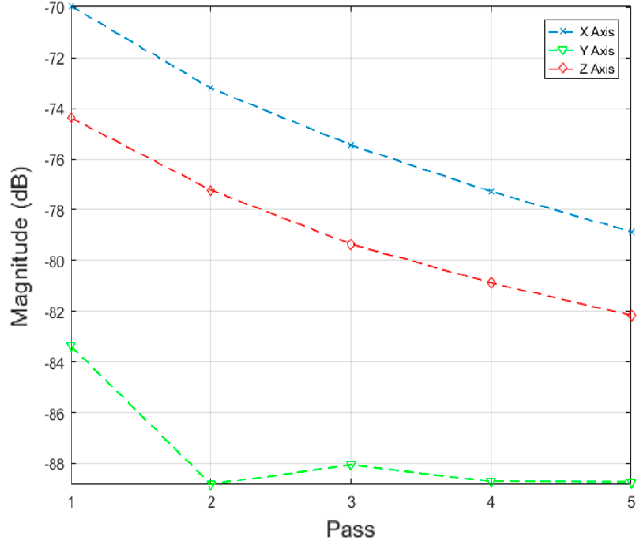
Figure 19. Signal magnitude vs. number of passes/cycle.